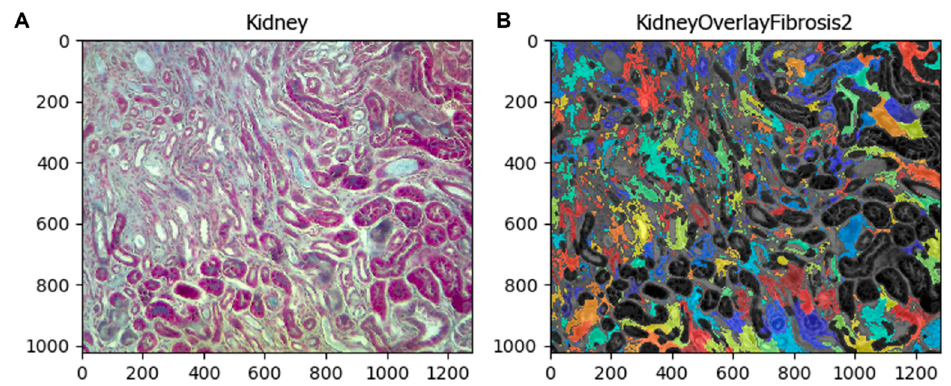
Figure 8. Comparison between the fibrotic area with the original image. ( A ) Original image, ( B ) merged image.